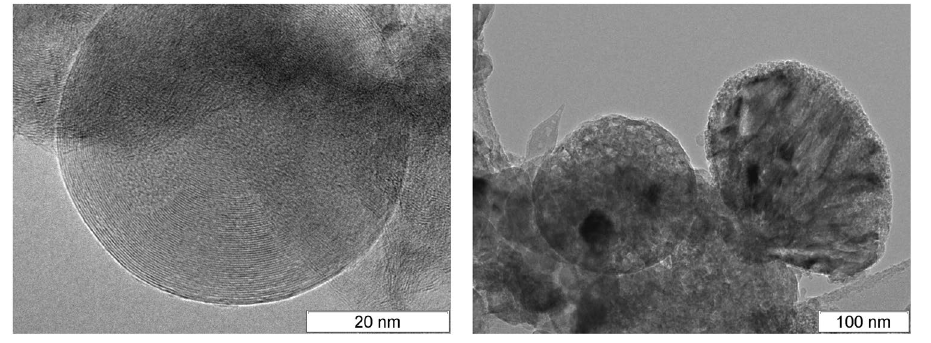
Figure 3. Carbon residuum of BTF